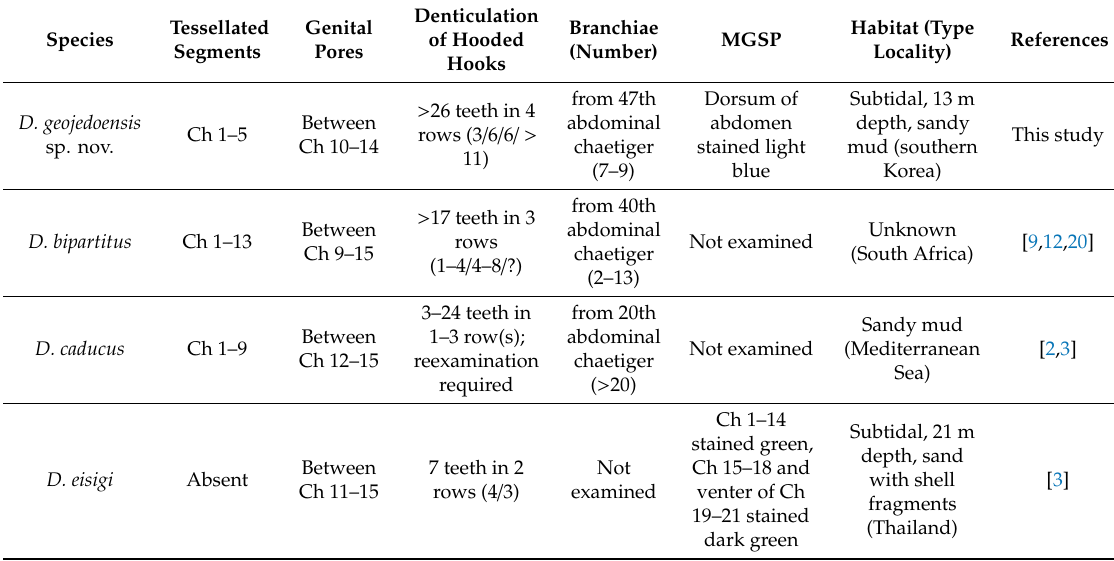
Table 2. Summary of the main morphological characters for a comparison of Dasybranchus geojedoensis sp. nov. with the closely related species. Ch,